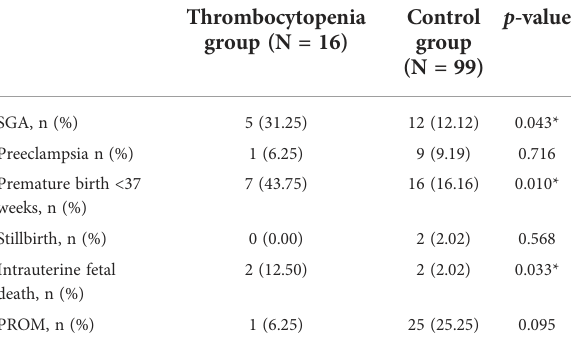
TABLE 2 Adverse pregnancy outcomes in the thrombocytopenia in the fi rst-trimester group and control group. Thrombocytopenia